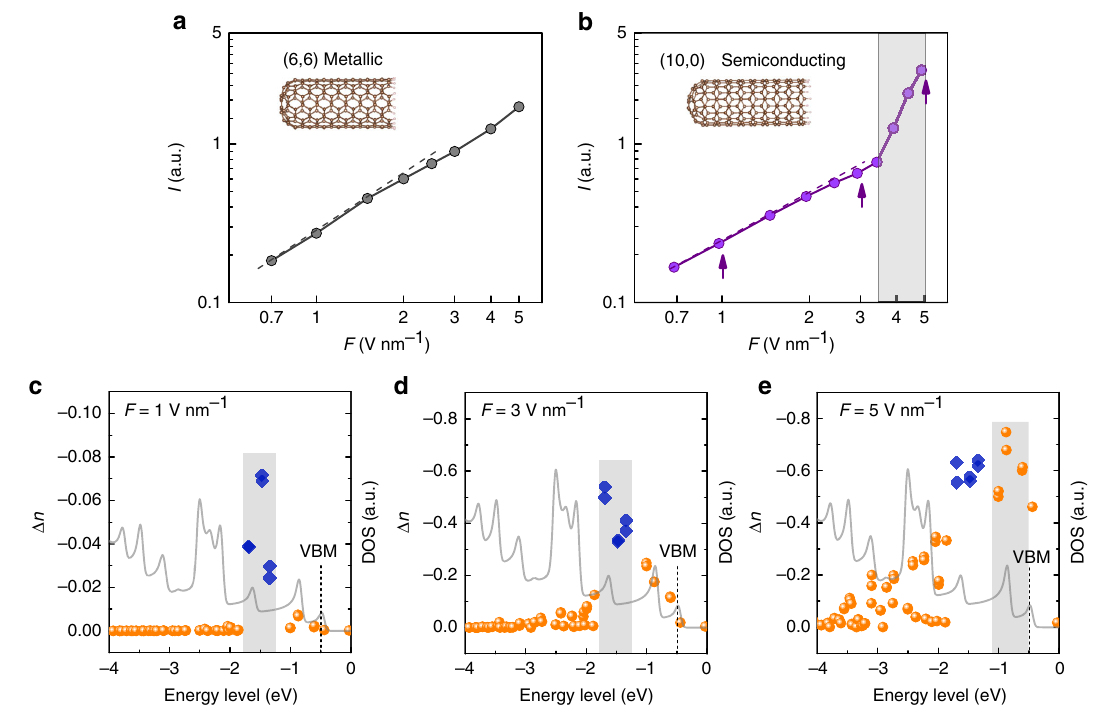
Fig. 3 OFE behavior revealed by TDDFT calculation. a The calculated I – F curve of (6,6) metallic CNT model. b The calculated I – F curve of (10,0) semiconducting CNT model. The simulated laser pulse is centered around 800 nm ( ℏ v = 1.55 eV) with a pulse width of 7 fs. MPP regime is indicated by a dashed line. Gray area indicates the curve bending up. c – e Excitation states of the semiconducting model (10,0) tube at three points marked by arrows in b . c At F = 1 V nm − 1 , the number ( Δ n ) of excited electrons clearly show a peak at − 1.5 eV (in gray area). Photon-driven electrons are represented by blue square dots, while fi eld-driven electrons are represented by yellow circular dots. d At F = 3 V nm − 1 , the peak is unchanged, which also indicates a photon- driven dominated regime. e At F = 5 V nm − 1 , the peak moves to − 0.9 eV, and the excitation number decreases rapidly as the energy level goes deeper, which demonstrates fi eld-driven tunneling behavior. The DOS data are plotted as a gray solid line in ( c – e ). VBM is marked by the dashed